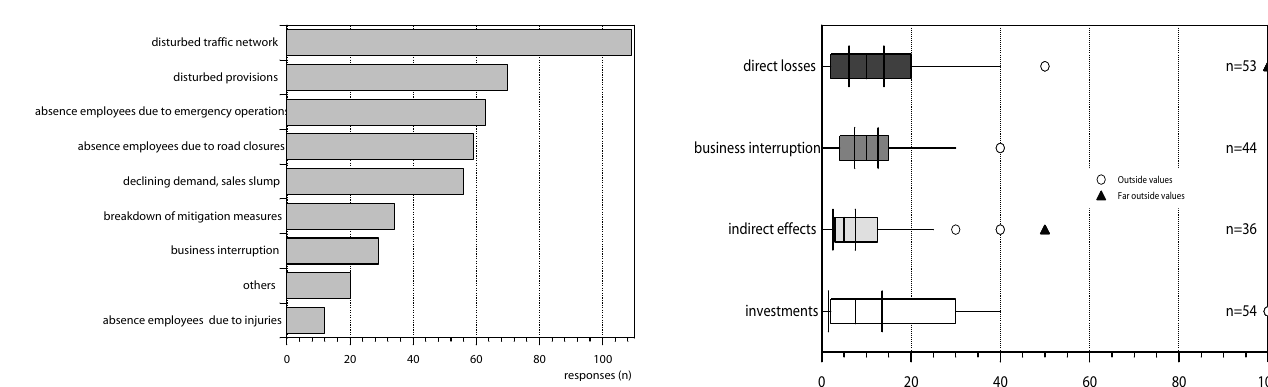
Fig. 2. Companies’ estimates of the triggers of indirect effects, mul- tiple responses, n = 145.